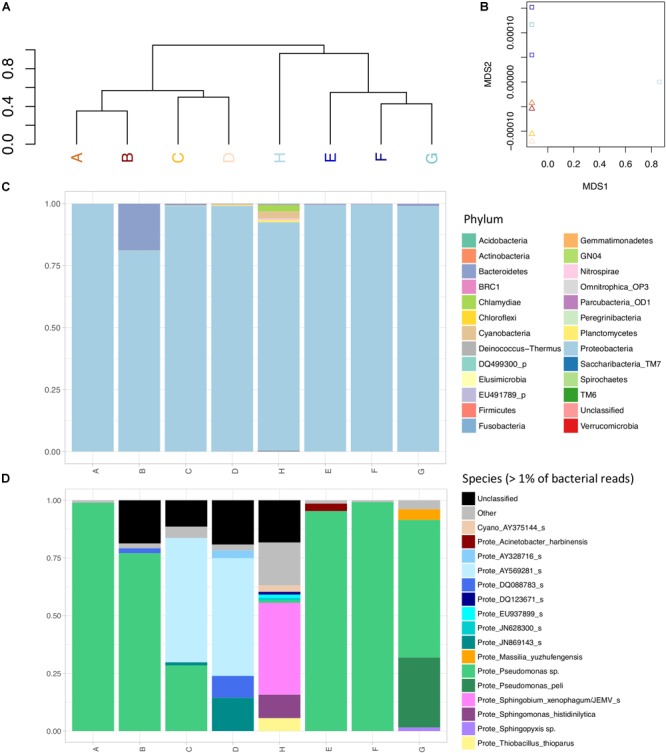
Taxonomic classification of 16S rRNA amplicons. (A) Hierarchical clustering of samples based on the presence/absence OTUs for City#1 (brown labels) and City#2 (blue labels) sampling sites. A gradient from dark to light colors reflects chlorine concentration at each site. (B) Non-metric multidimensional scaling plot of the sample based on the presence/absence and the quantification of reads classified in bacterial OTUs (Ward distance), displayed with the same color-code as in (A). (C) Bacterial composition at the phylum level, showing the large predominance of Proteobacteria, and some Bacteroidetes, Cyanobacteria, and Chlamydiales in a few samples. (D) Bacterial composition at the species level, showing the large predominance of Pseudomonas spp. in the samples with higher chlorine, and the abundance of unknown proteobacterial clades as well as Sphingomonales in samples with lower chlorine concentration. Only identified species encompassing more than 1% of reads were represented in (D).